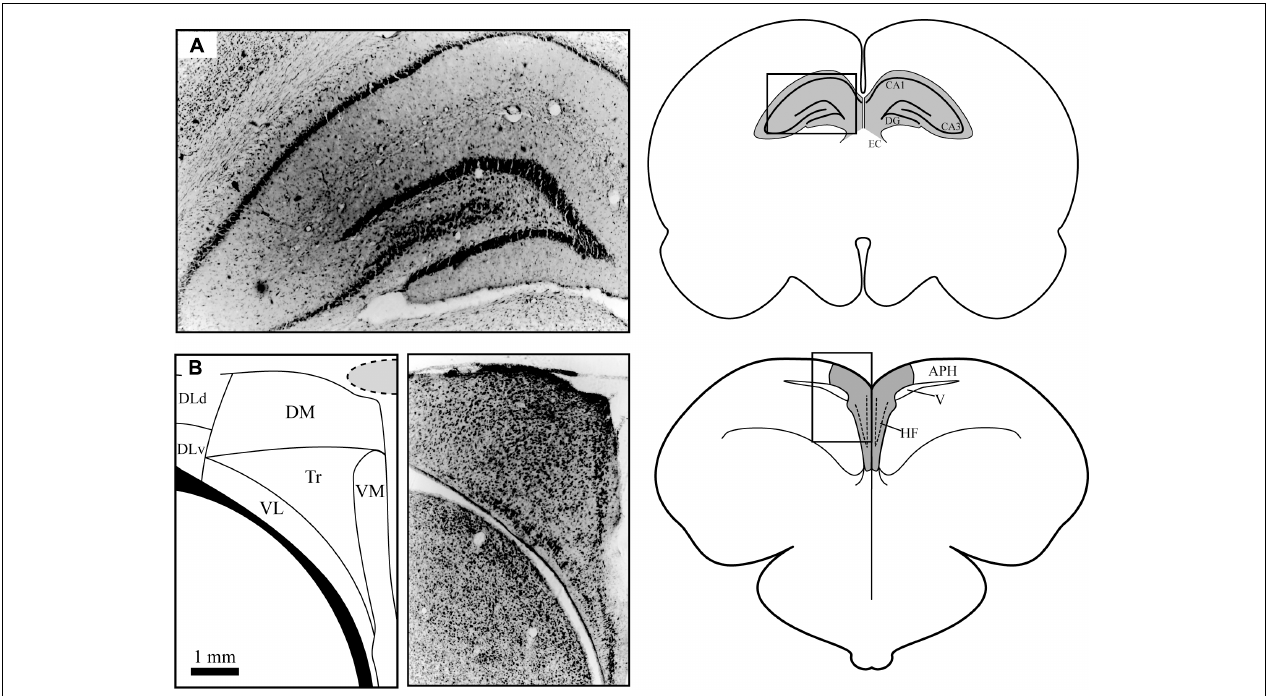
FIGURE 1 | Anatomical differences between mammalian (A) and homing pigeon (B) brain anatomy. (A) The mammalian hippocampus (shaded) is located under a significant amount of neocortex (approximately 3 mm). The simplified flow of information through this structure is as follows: from entorhinal cortex (EC) to Ammon’s Horn CA3 to Ammon’s Horn CA1 to dentate gyrus (DG) and then back to EC. (B) The pigeon hippocampal formation (shaded) is a dorsomedial structure that overlies the lateral ventricle on the surface of the brain. The subdivisions in the avian HF include the following areas: dorsal and ventral dorsolateral (DLd and DLv respectively), dorsomedial (DM), ventrolateral and ventromedial dense cell layers (VL and VM, respectively), and the triangular subdivision (Tr). The area parahippocampal (APH) is not considered to be part of the avian HF but has substantial connections to it. The location of the overlying central sinus blood vessel is indicated by the shaded area. Photomicrographs of cresyl violet stained tissue were taken by the author. Pigeon subdivisions are based on Atoji and Wild